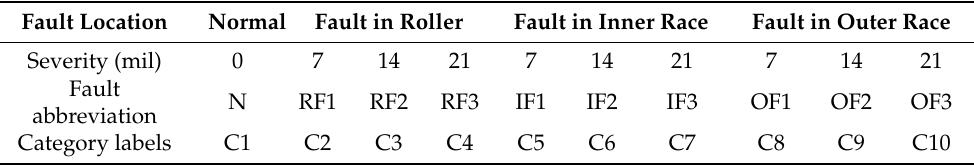
Figure 4. The experiment platform of Case Western Reserve University. Table 2. Data setting parameters table of open datasets.